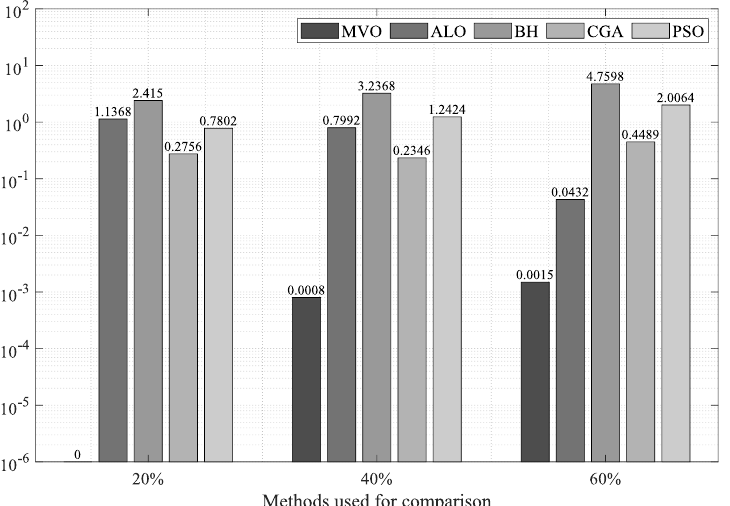
Figure 5. Standard deviation obtained by the SSA in the 21-node system compared to that of the other methodologies.